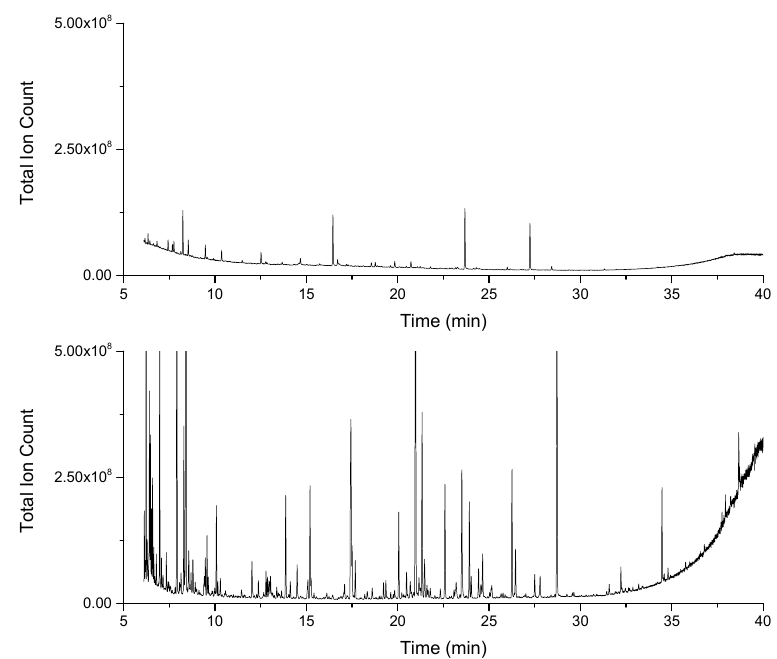
Figure 1. Chromatograms from preliminary experiments before sample concentration adjustment. Chromatograms show derivatized Skeletonema costatum extracts with a concentration equivalent to 2.5 × 10 3 cells per µL sample measured on the Orbitrap GC (bottom), with a split ratio of 1:5, and the GC-ISQ (top), with a split ratio of 1:8 (minimal split ratios on each machine).